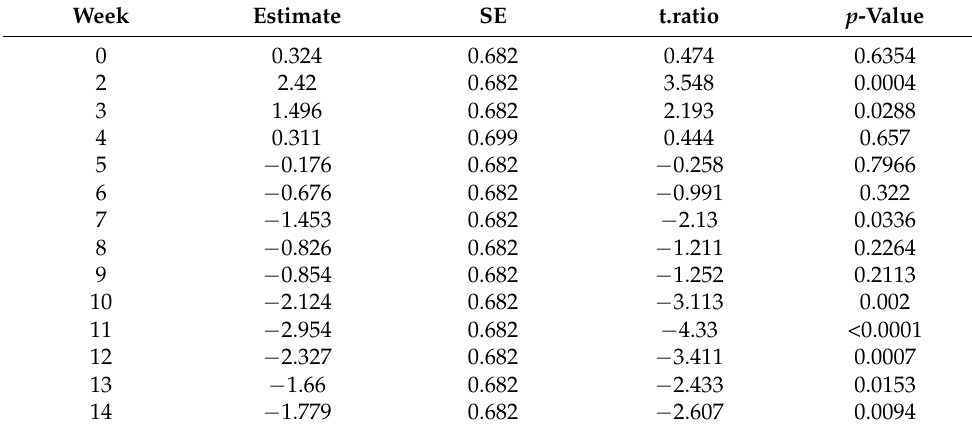
Table A8. Pairwise comparison for number of flowers over the 14-week in LD treatment at 20 ◦ C between cultivars, ‘Florentina’ and ‘Favori’.